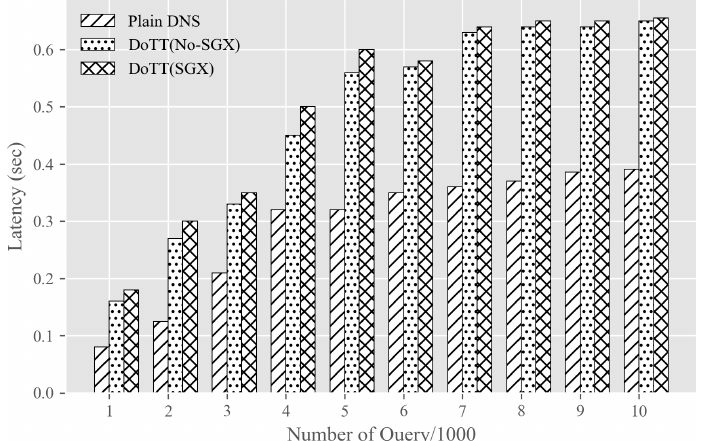
Figure 3. The latency of response among the plain DNS, DoTT (Non-SGX), and DoTT (SGX)